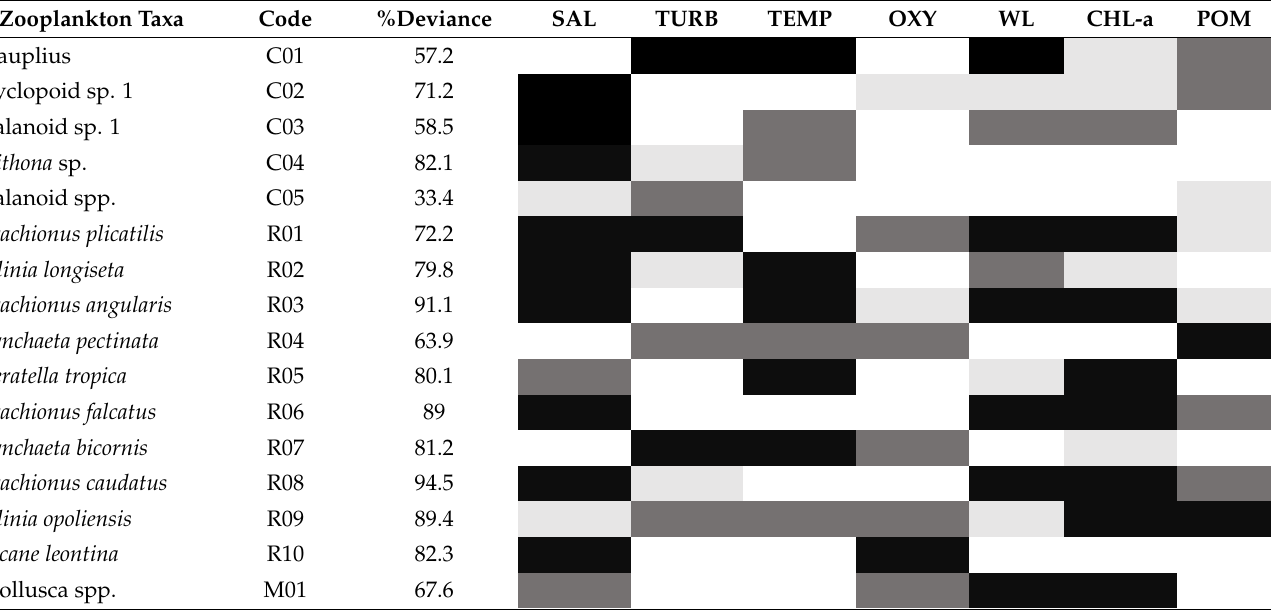
Table 4. Each row summarizes the GAM for that particular taxa: percent deviance explained (%Deviance) and significance of each environmental variable. Black cells represent p -values < 0.001, dark gray cells represent p -values < 0.01, light gray cells represent p -values < 0.05, and white cells represent non-significant p